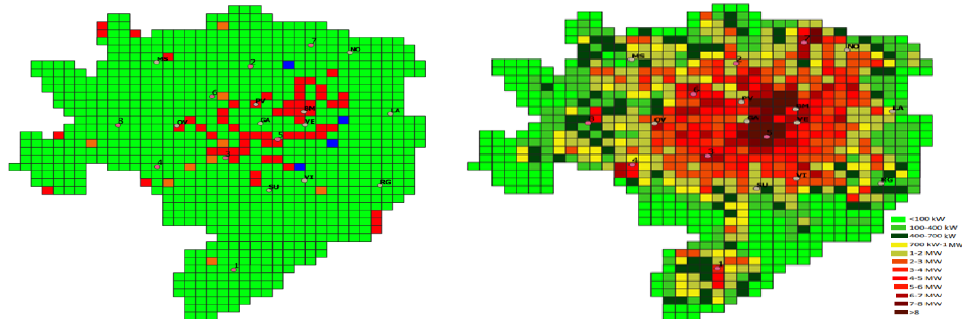
Figure 22. Output of the simulation results considering eight new PSs. Pink points are the new PSs, while gray are the existing ones.